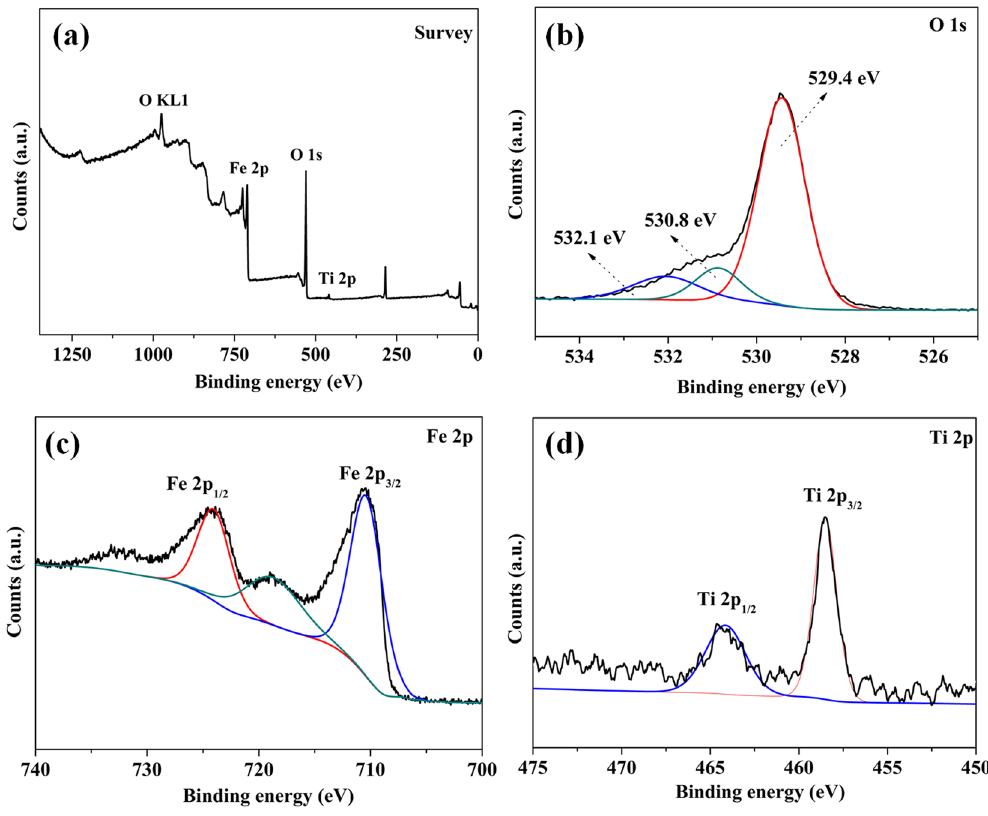
Figure 3. XPS patterns of TiO 2 /Fe 2 O 3 -5.